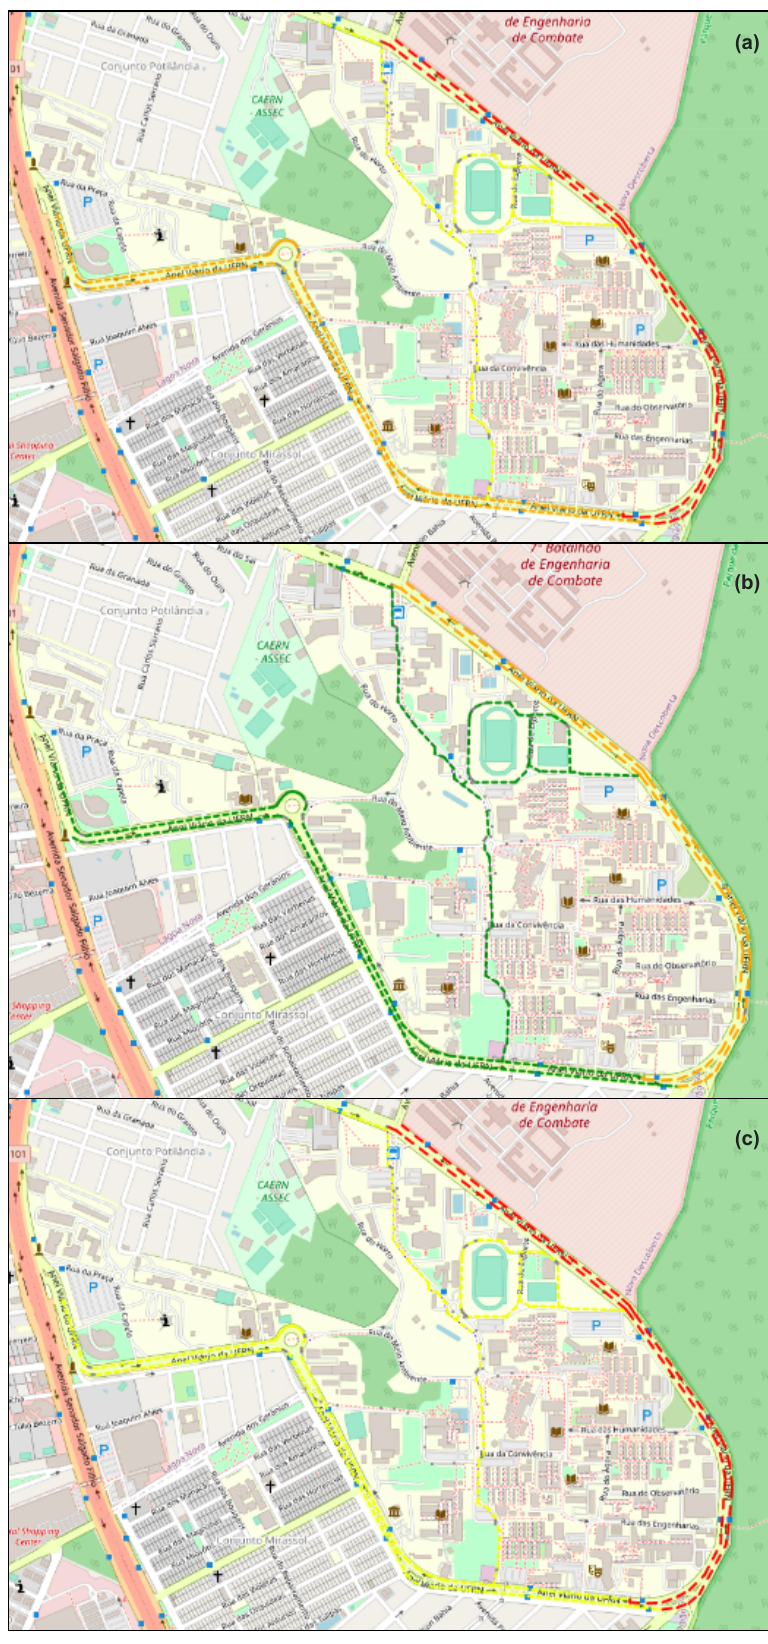
Figure 14. Maps for each phase defined for 2020 with the registered cycle paths and their respective qualities. ( a ) Pre-pandemic phase; ( b ) Severe restrictions phase; ( c ) Relaxation of restrictions